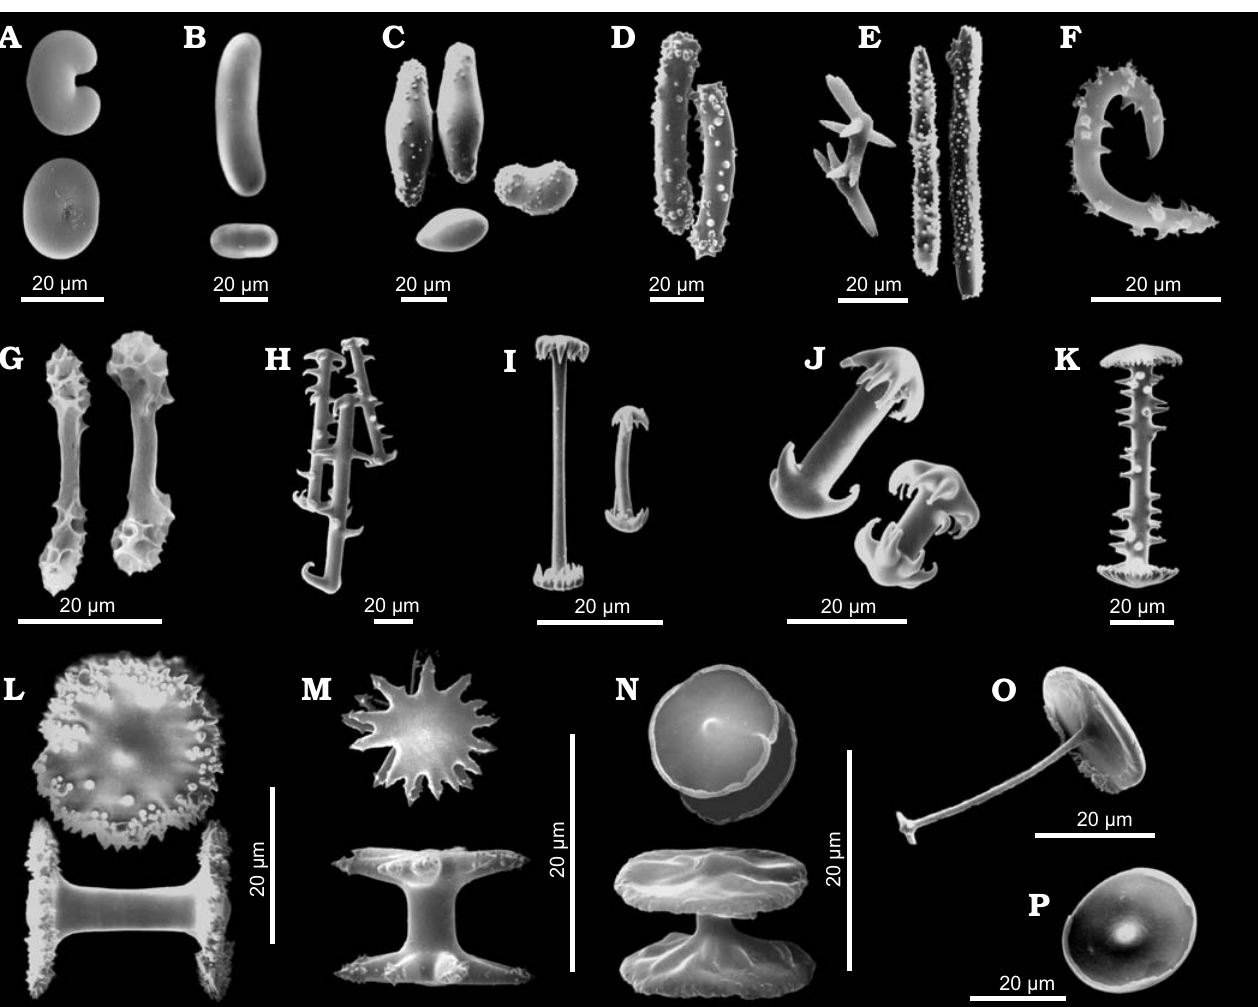
Fig. 5. Morphology of gemmuloscleres of Recent freshwater sponges of the order Spongillida. A . Cherokeesia armata Copeland, Pronzato, and Manconi, 2015, Nearctic Region, bean-like to ovoid strongyles. B . Potamophloios stendelli (Jaffé, 1916), Afrotropical Region, elongate to ovular strongyles. C . Oncosclera jewelli (Volkmer-Ribeiro, 1963), Neotropical Region, irregularly ovoid strongyles smooth or covered with short spines and tubercles. D . Corvospongilla loricata (Weltner, 1895), Afrotropical Region, slightly curved, stout, spiny strongyles. E . Sanidastra yokotonensis Volkmer-Ribeiro and Watanabe, 1983, Palaearctic Region, oxeas with 2–9 rays rounded to pointed or tricuspidate at tips. F . Spongilla lacustris (Linnaeus, 1759), Nearctic- Palaearctic Region, oxeas strongly bent with large spines. G . Pectispongilla aurea Annandale, 1909, Oriental Region, botryoidal gemmuloscleres with smooth shaft with at the apex polygonal concavities of the botryum. H . Anheteromeyenia argyrosperma (Potts, 1880), Nearctic Region, birotules with spiny shafts and circular rotules with crenulated to indented margins. I . Corvomeyenia everetti (Mills, 1884), Nearctic Region, pseudobirotules with straight, smooth shafts and pseudo-rotules at the apex (up to 10 hooks). J . Acalle recurvata (Bowerbank, 1863), Neotropical Region, pseudobirotules with cylindrical shaft and hooks of umbonate pseudorotules stout and notably recurved bearing microspines at their apices. K . Dosilia plumosa (Carter, 1849), Oriental Region, birotules with large spines on the straight shaft and flat to slightly umbonate rotules with margins bearing small blunt, recurved teeth (spines). L . Racekiela ryderi (Potts, 1882), Nearctic-Neotropical-Palaearctic Region, birotules with smooth shafts and large disk-like rotules with serrated margins and scattered spines or tuber- cles. M . Ephydatia muelleri (Lieberkühn, 1855), Afrotropical-Nearctic-Palaearctic Region, birotules with smooth, short shaft and rotules with indented margins. N . Trochospongilla horrida (Weltner, 1893), Nearctic-Palaearctic Region, birotules with smooth, short shaft and approximately circular rotules with irregularly thickened margins. O . Acalle recurvata (Bowerbank, 1863), Neotropical Region, tubelliform gemmuloscleres with the proximal large irregularly circular flat rotule with entire margin supporting a smooth shaft decreasing in thickness toward the distal end shaped as umbonate knob-like rotule with a few teeth. P . Drulia browni (Bowerbank, 1863), Neotropical Region, parmuliform gemmuloscleres with the single circular proximal rotule, with lower concave surface, supporting a distal short acute conical stem (shaft). SEM images. Modified from Manconi and Pronzato (2001, 2002) and Copeland et al.